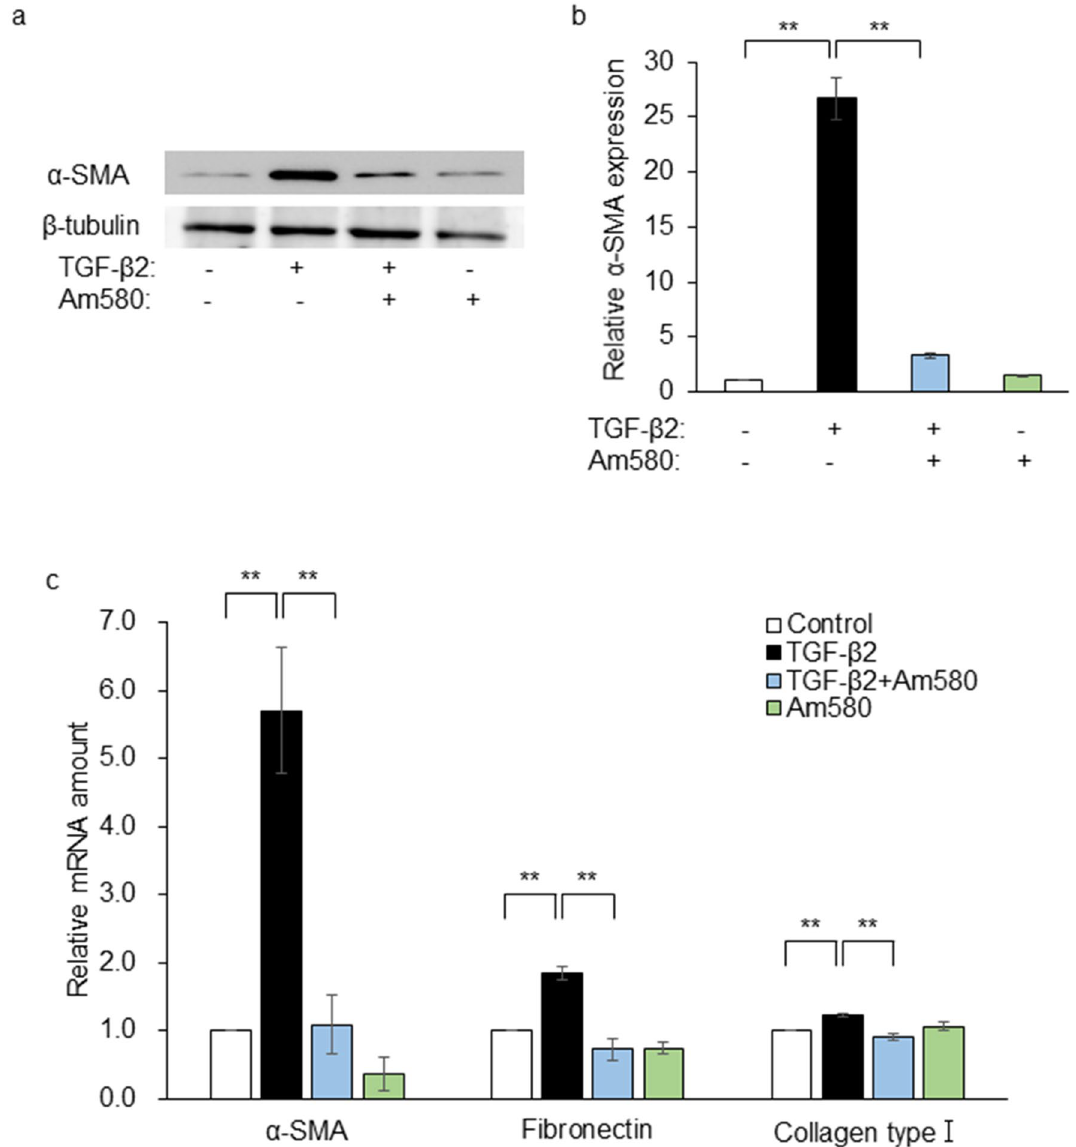
Figure 2. Inhibitory effects of an RAR-α agonist on the TGF-β2-induced expression of EMT markers in RPE cells. ( a ) RPE cells were cultured in collagen gels with or without TGF-β2 (1 ng/ml) and Am580 (10 µM) for 48 h, after which cell lysates were prepared and subjected to immunoblot analysis with antibodies to α-SMA and to β-tubulin (loading control). ( b ) The intensity of each α-SMA band in blots similar to that in ( a ) was normalized by that of the corresponding β-tubulin band, and the normalized values were expressed relative to that for control cells and are presented as means ± s.d from three independent experiments. The intensity of each immunoreactive bands was measured with the use of the Gels commands in ImageJ software. ( c ) Serum- deprived RPE cells were cultured in 24-well plates first with or without Am580 (10 μM) for 6 h and then in the additional absence or presence of TGF-β2 (1 ng/ml) for 48 h, after which the relative abundance of α-SMA, fibronectin, and collagen type I mRNAs was determined by RT-qPCR analysis. Data were normalized by the amount of GAPDH mRNA and are means ± s.d. from three independent experiments. ** P < 0.01 (Dunnett’s